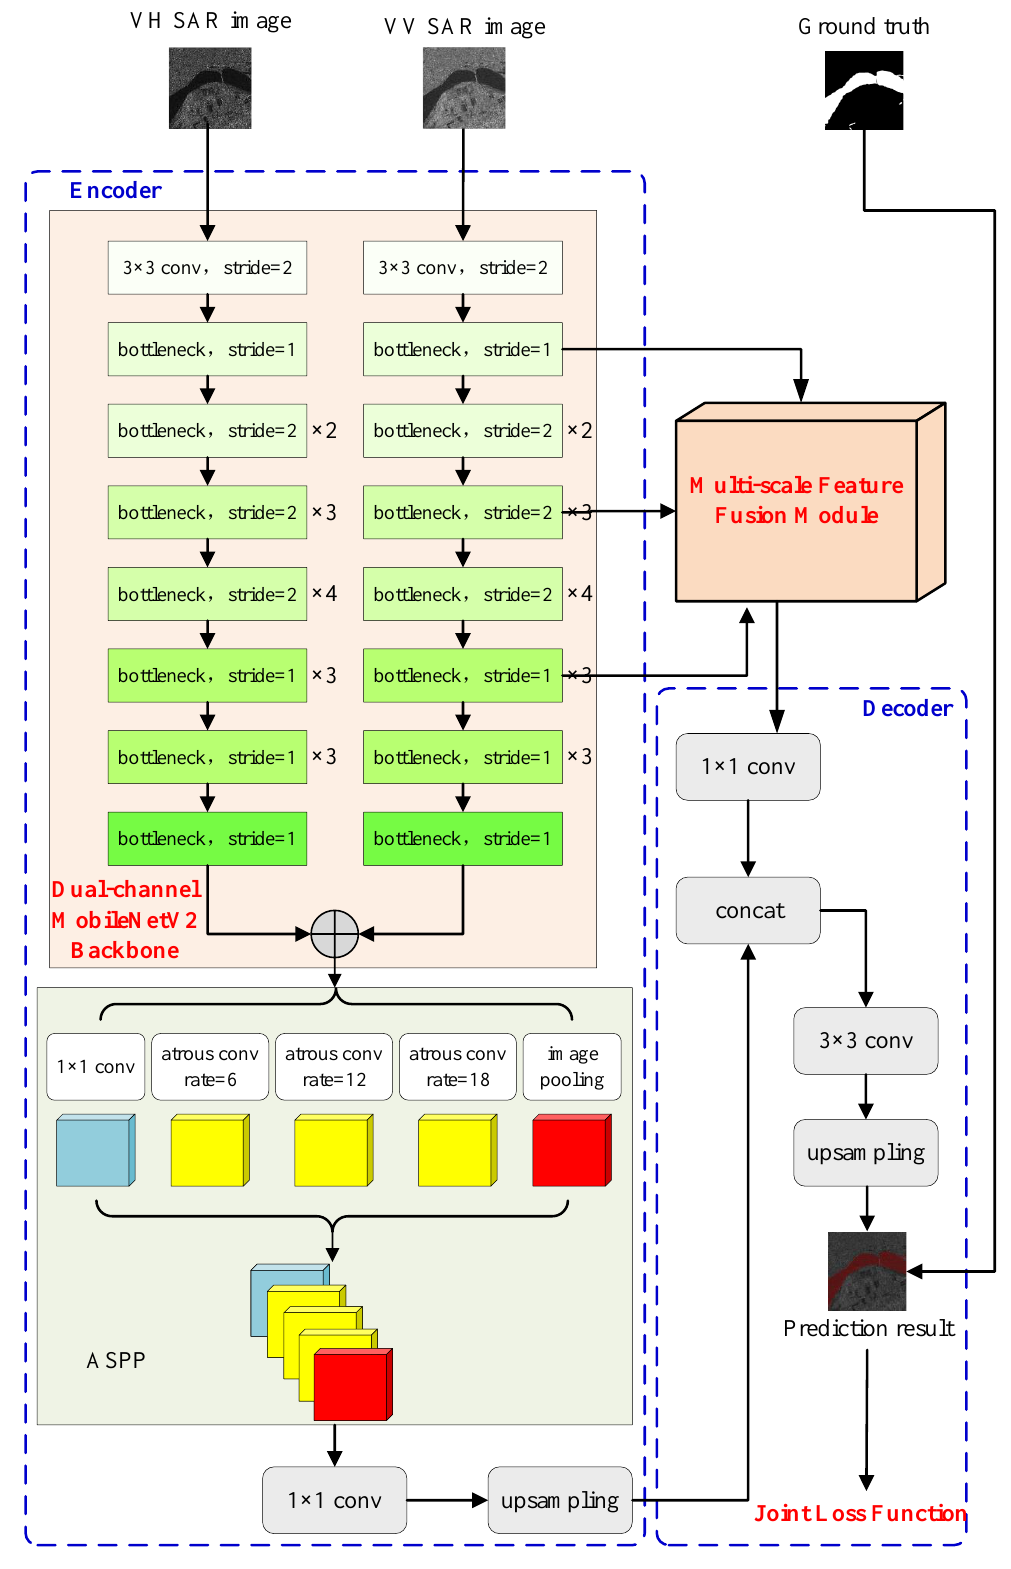
Figure 7. The schematic diagram of the proposed MS-Deeplab